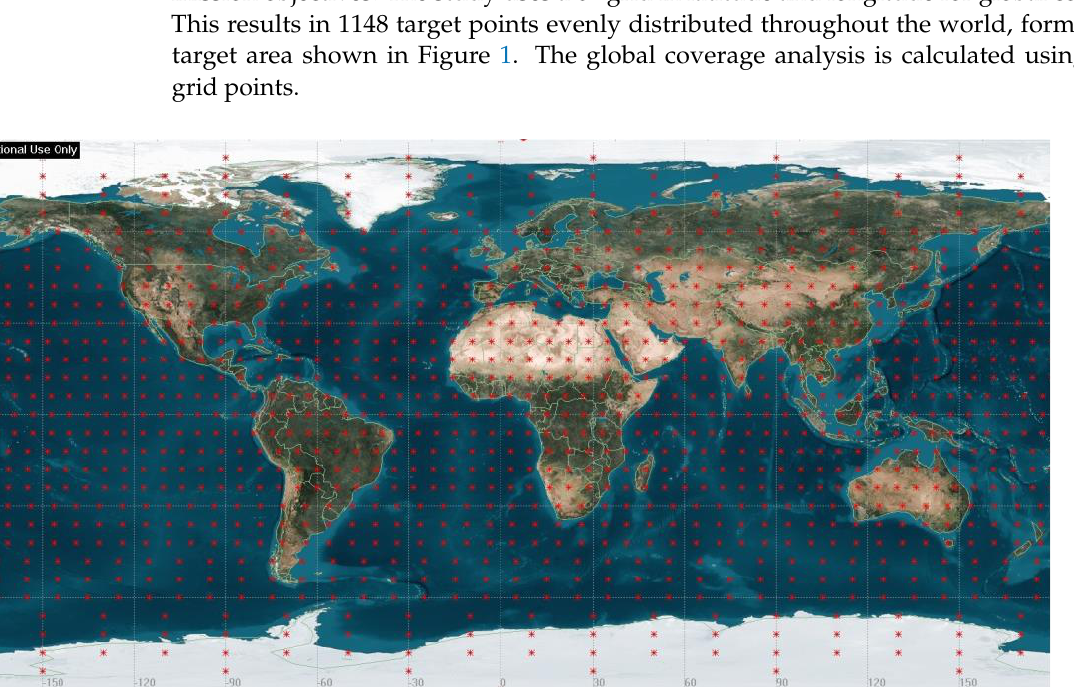
Figure 1. Distribution of global target area with 6° grid in latitude and longitude.